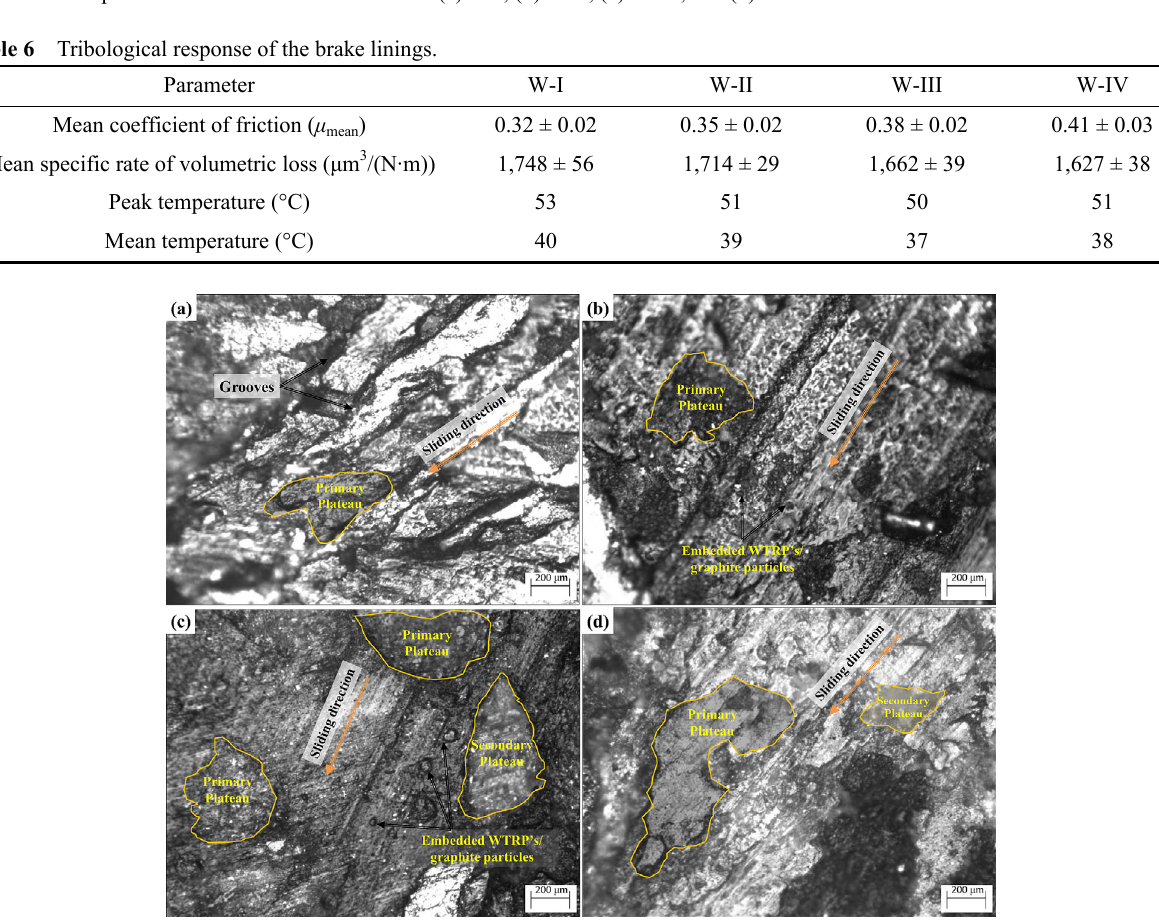
Fig. 11 Wear micrographs to characterize primary and secondary plateau: (a) W-I, (b) W-II, (c) W-III, and (d)